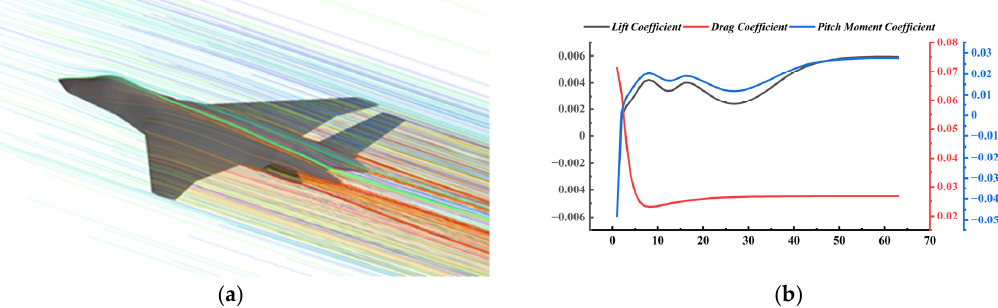
Figure 3. CFD calculation process: ( a ) the path lines and ( b ) the aerodynamic coefficient iteration process.